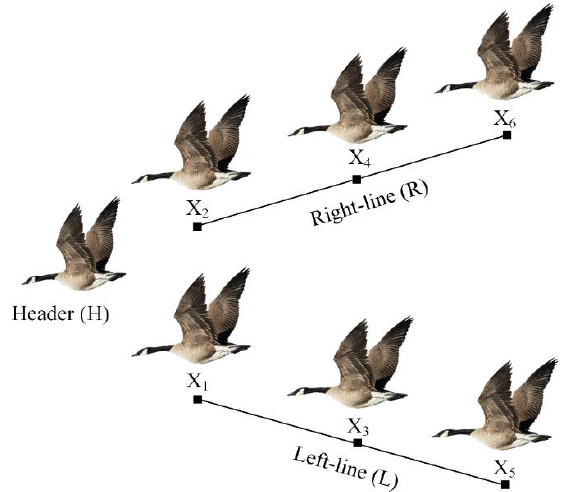
Figure 1. The V-shaped formation consists of a header (H), left-line (L), and right-line (R)